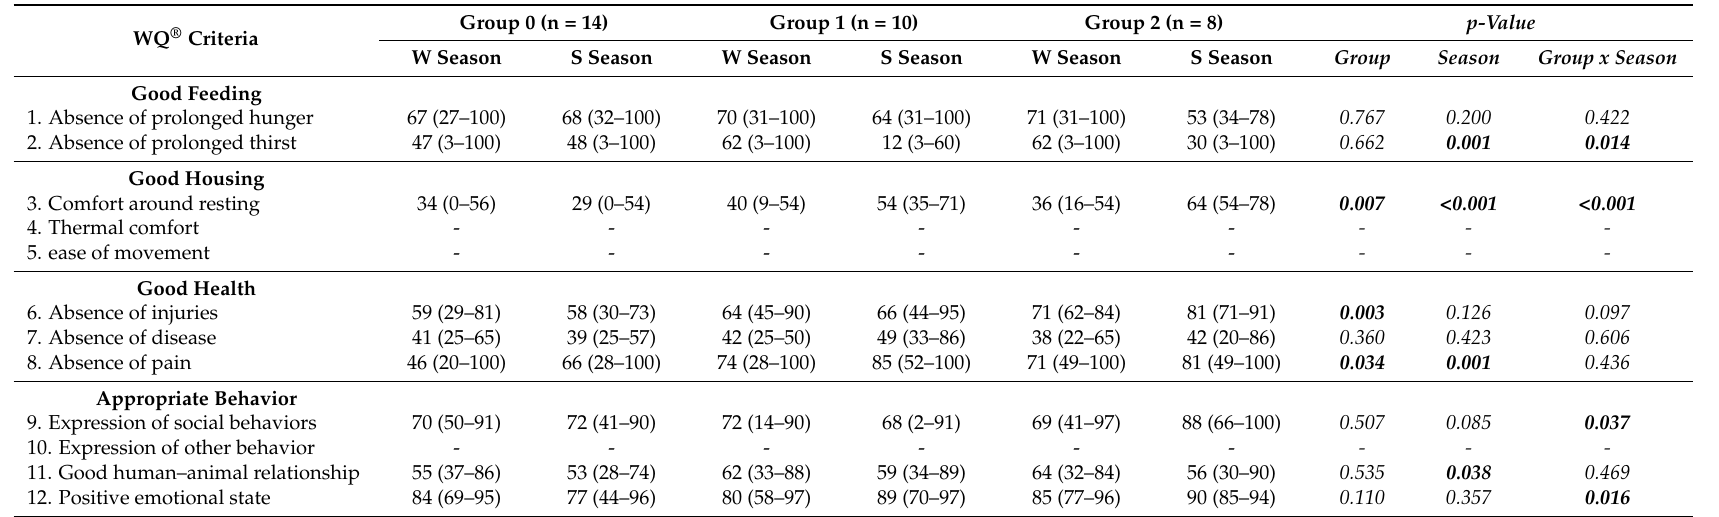
Table 3. Four WQ ® principles divided in twelve WQ ® criteria, scores (mean (min-max)) for three groups (Groups 0, 1, and 2) and two seasons (W = winter and S = summer). Highlighted in bold are p -values that are p <